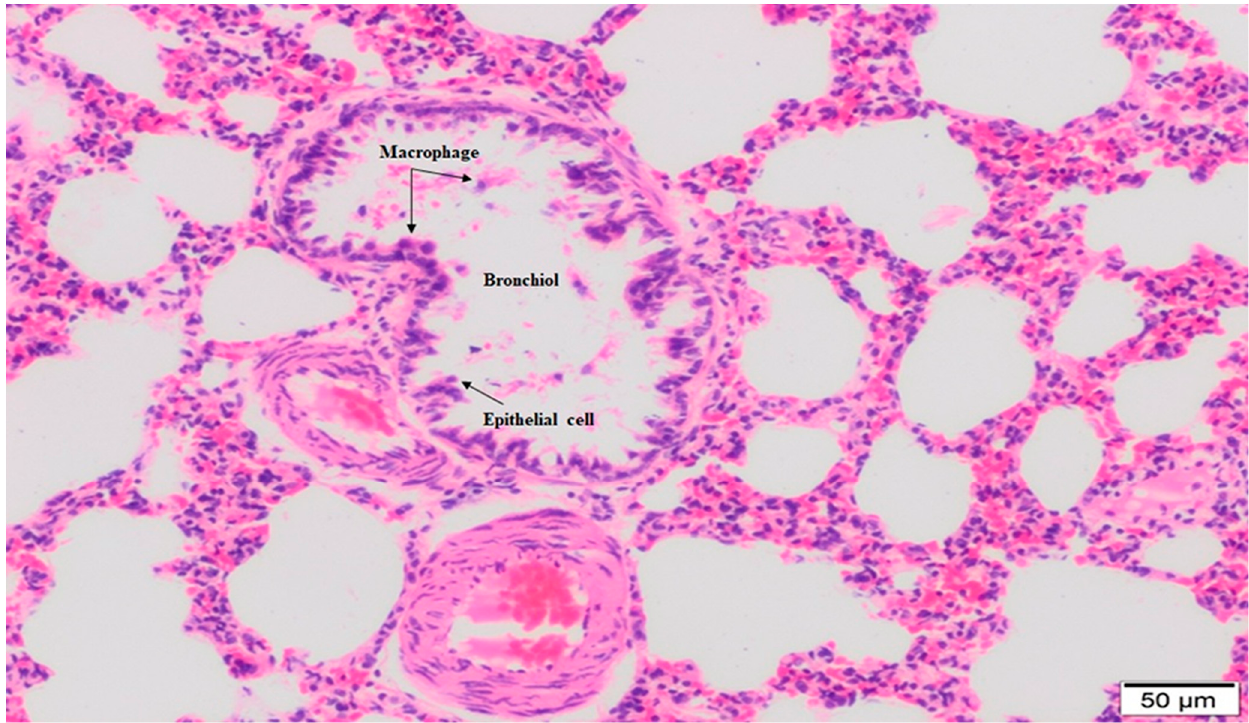
Figure 3. In the lung histology of the 15% NaOCl group, alveolar disruption, infiltrative cells around the vessels, and, in the alveolar area, interalveolar macrophages and neutrophils were observed. Hemorrhage, edema in the interstitial area, and disruption in the interalveolar septum were observed. It was observed that the alveoli were full, the continuity of the epithelium of the respiratory bronchioles was disrupted, and there was an increase in interstitial cells between the alveoli and edema around the vessels (20 × magnification).